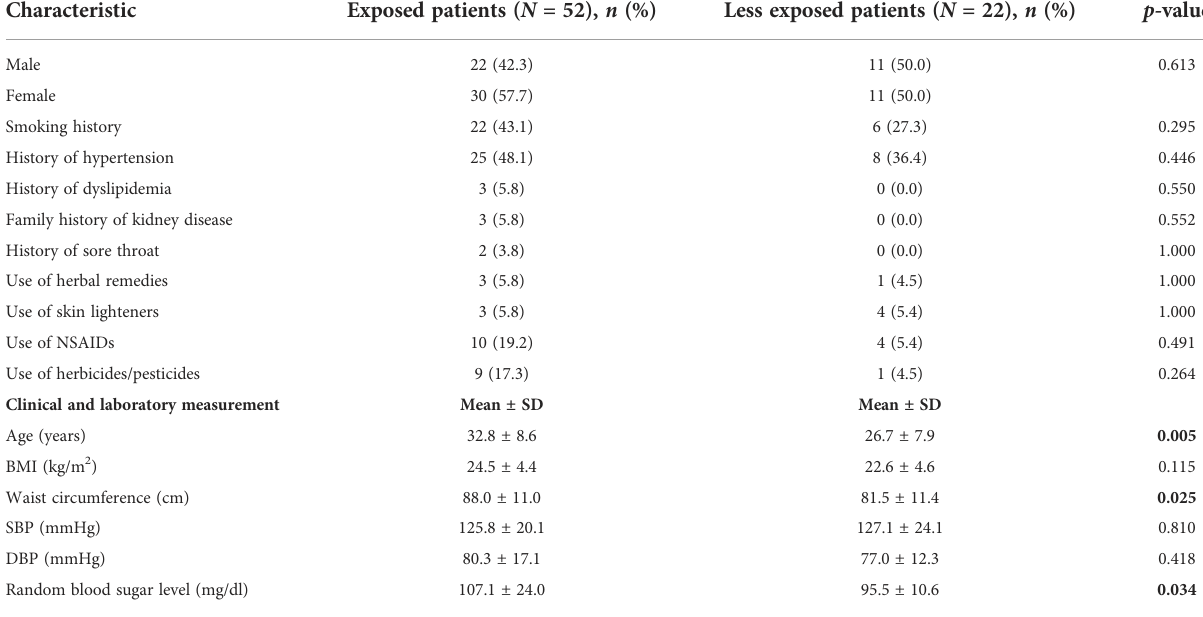
TABLE 3 Comparison of traditional chronic kidney disease (CKD) risk factors among exposed and less exposed CKD patients. Characteristic